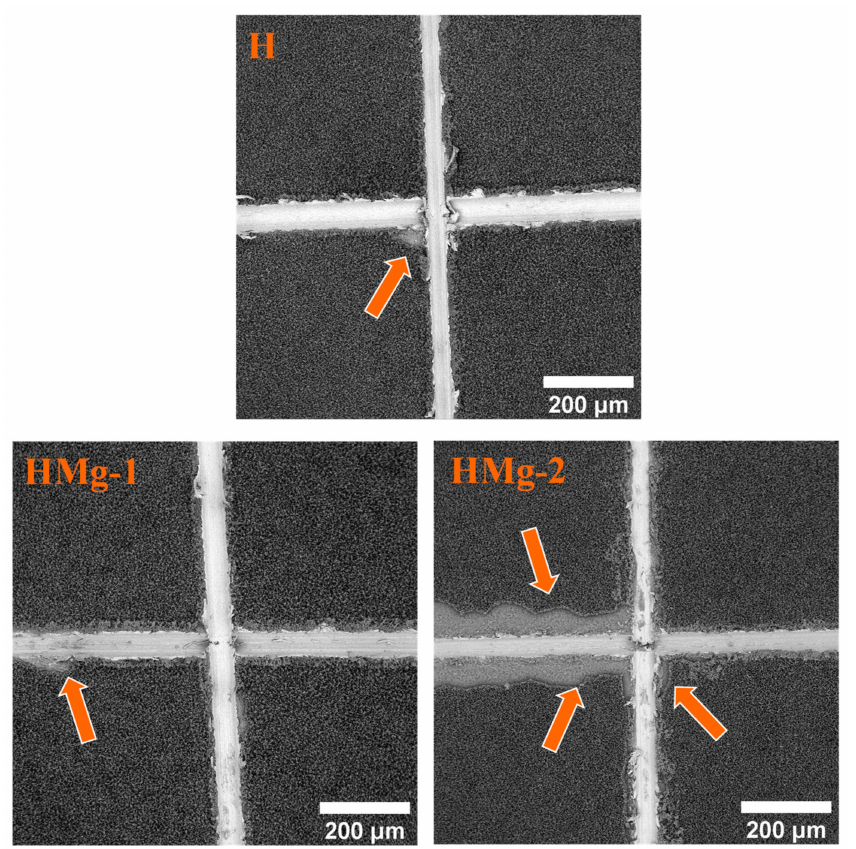
Figure 8. SEM images of the coatings deposited on the nanostructured surface after the adhesion test; the arrows indicate the detached areas (see Figure S4 in supplementary file for the original SEM